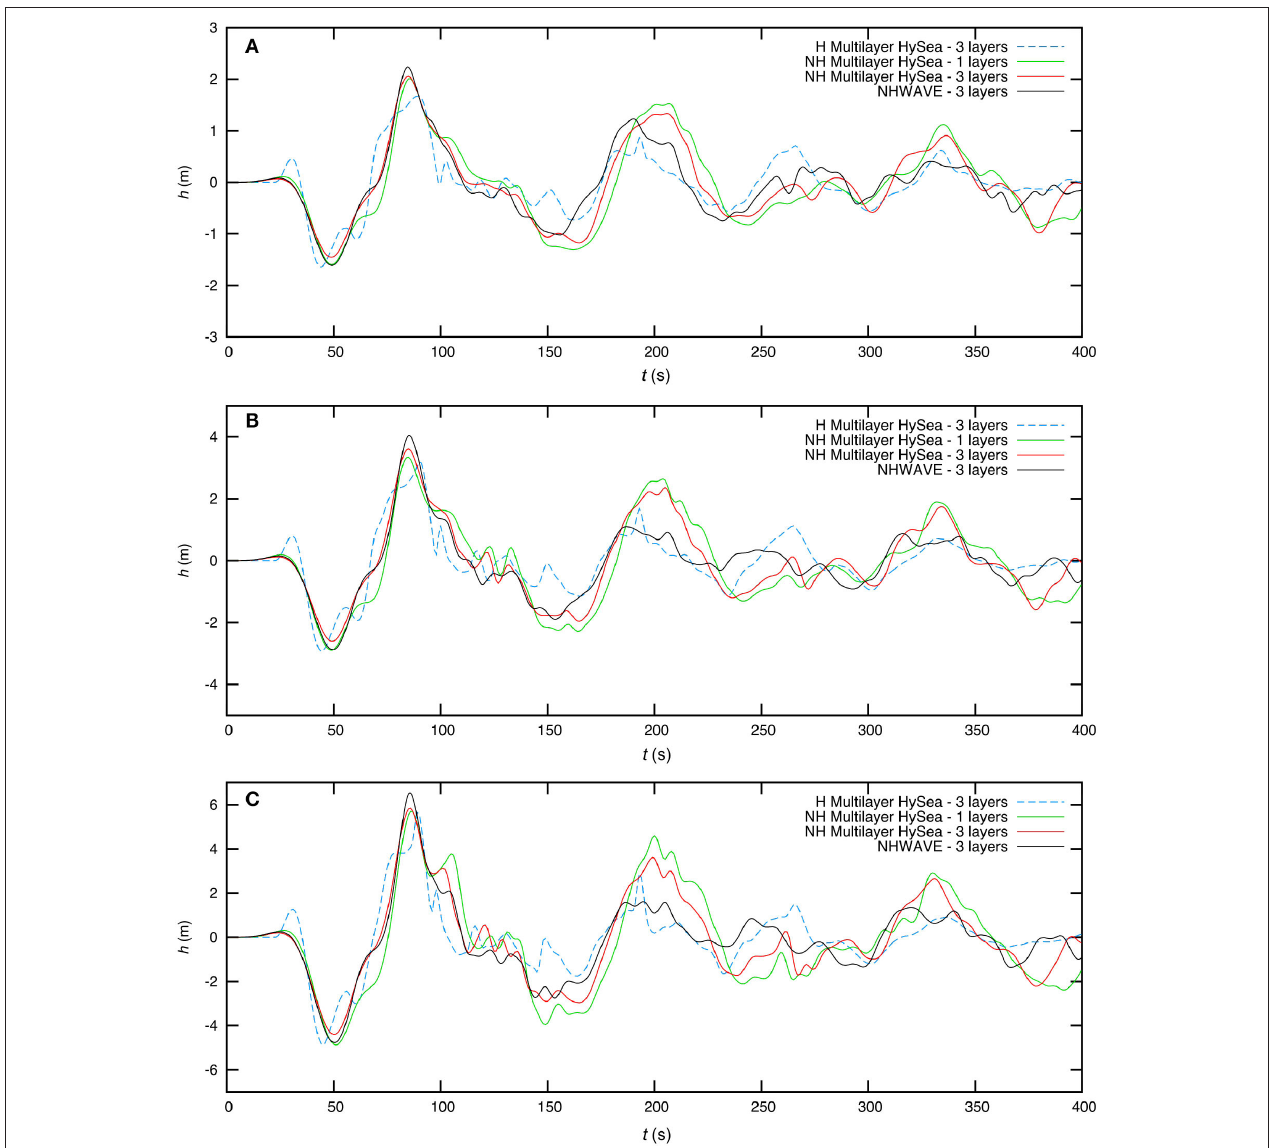
FIGURE 3 | Wave forms at gauge 1 simulated with different wave models with a rigid landslide (A) V = 7.1 × 10 6 m 3 , (B) V = 11.8 × 10 6 m 3 , and (C) V = 17.6 × 10 6 m 3